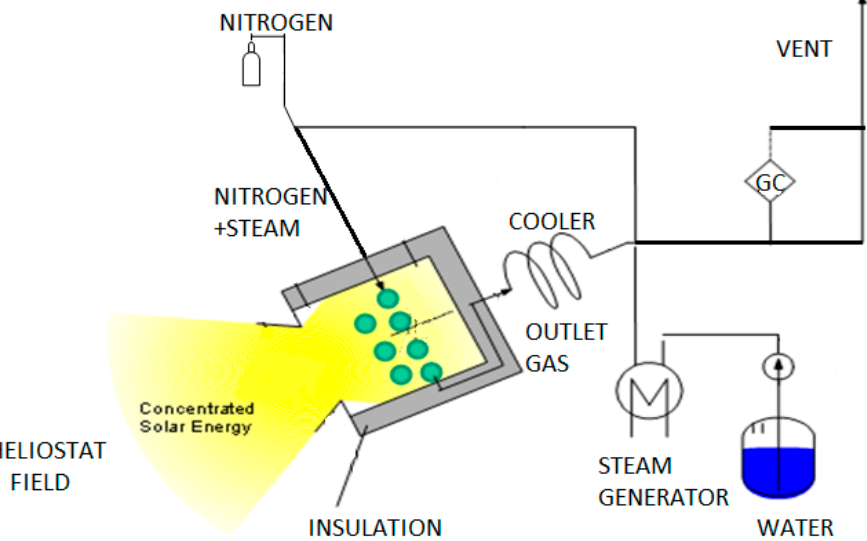
Figure 2. Sketch of the solar reactor